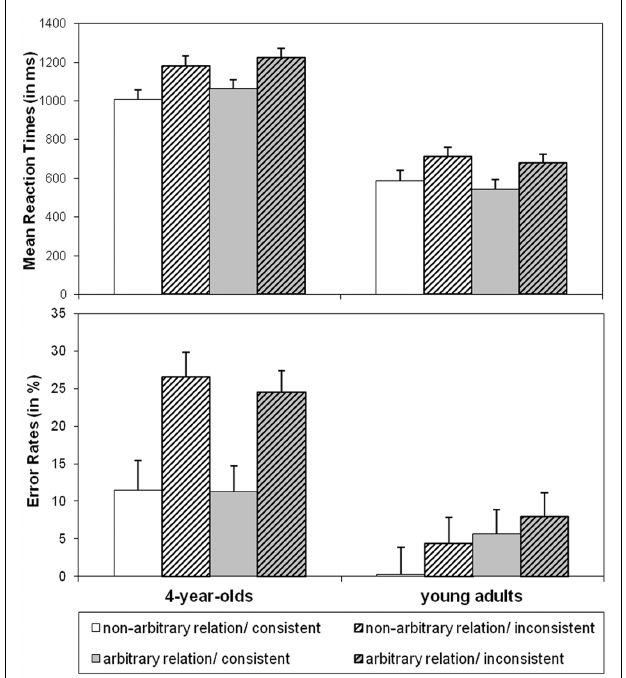
FIGURE 1 | Mean RTs (upper panel) and percentages of errors (lower panel) for performance on arbitrary and non-arbitrary sound–action relations as a function of age and